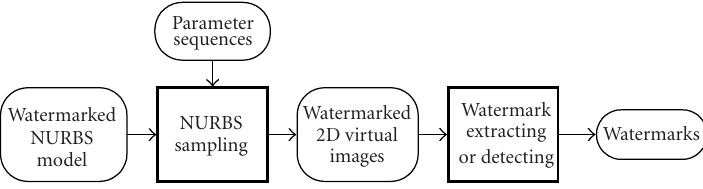
Figure 2: Block diagram of extracting or detecting